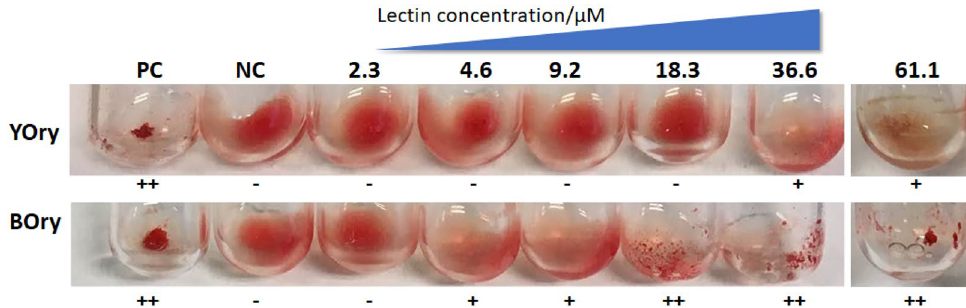
Figure 4. Agglutination activity of YOry and BOry. Trypsin-treated red blood cells (RBCs) from rabbit were used for the agglutination assays. After mixing the RBCs with different concentrations of the lectin, agglutination of the RBCs was scored. The lectin HHA was used as the positive control (PC), and PBS was used as the negative control (NC). + + and + indicate a strong and good agglutination, respectively, while – indicates no agglutination.